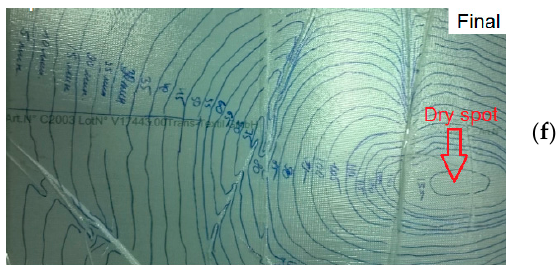
Figure 2. The sequence of the snapshots, which demonstrate the resin front propagation in the vacuum infused rectangular CFRP panel.